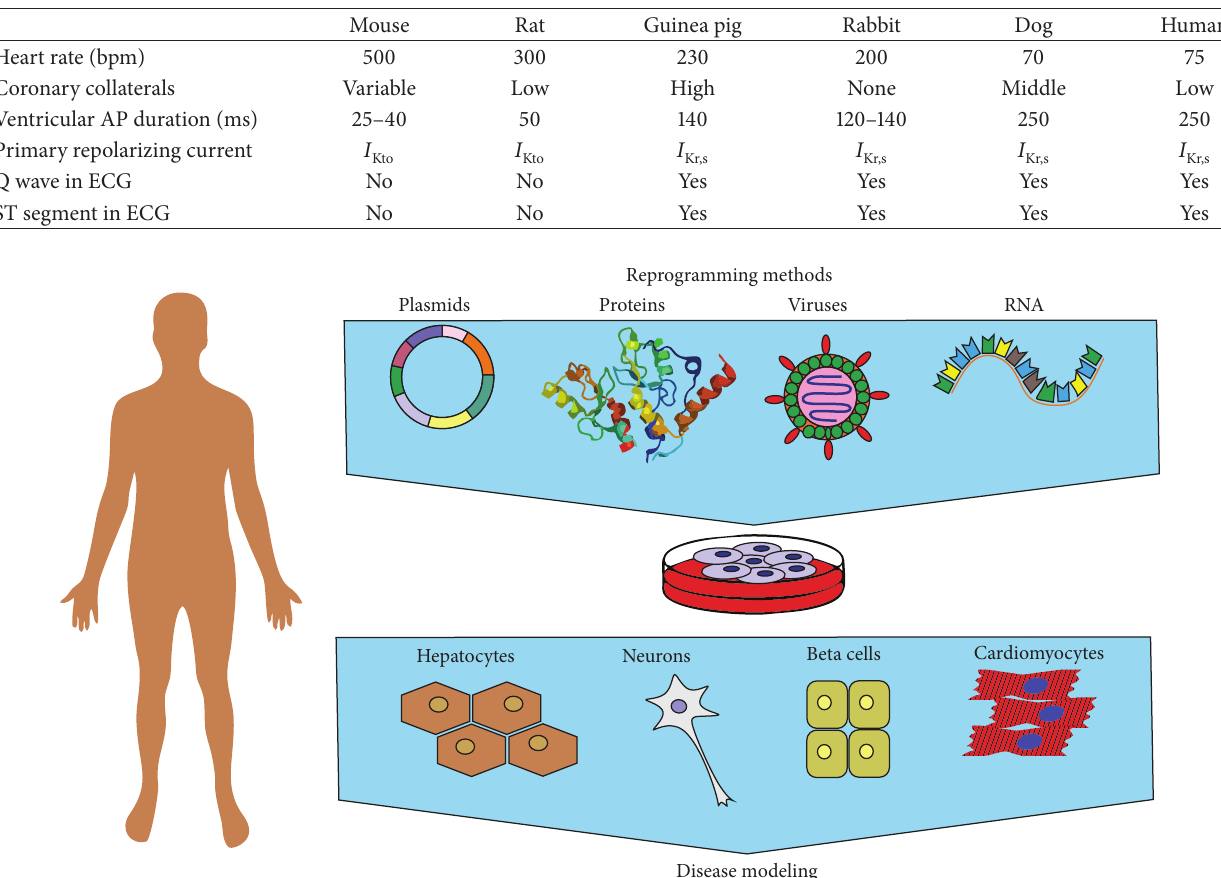
Table 1: Electrophysiological characteristics of heart that differ in humans and laboratory animals (modified from [91]).